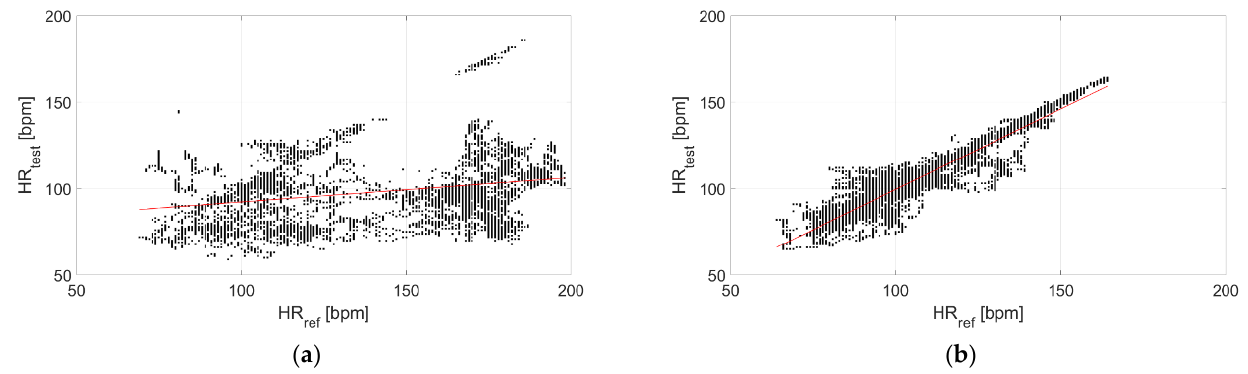
Figure 9. Correlation of measurements performed through Garmin Venu Sq with respect to the reference sensor (Polar H10) related to ( a ) In-water and ( b ) Dry acquisitions, including recordings both at rest and during moderate physical activities.